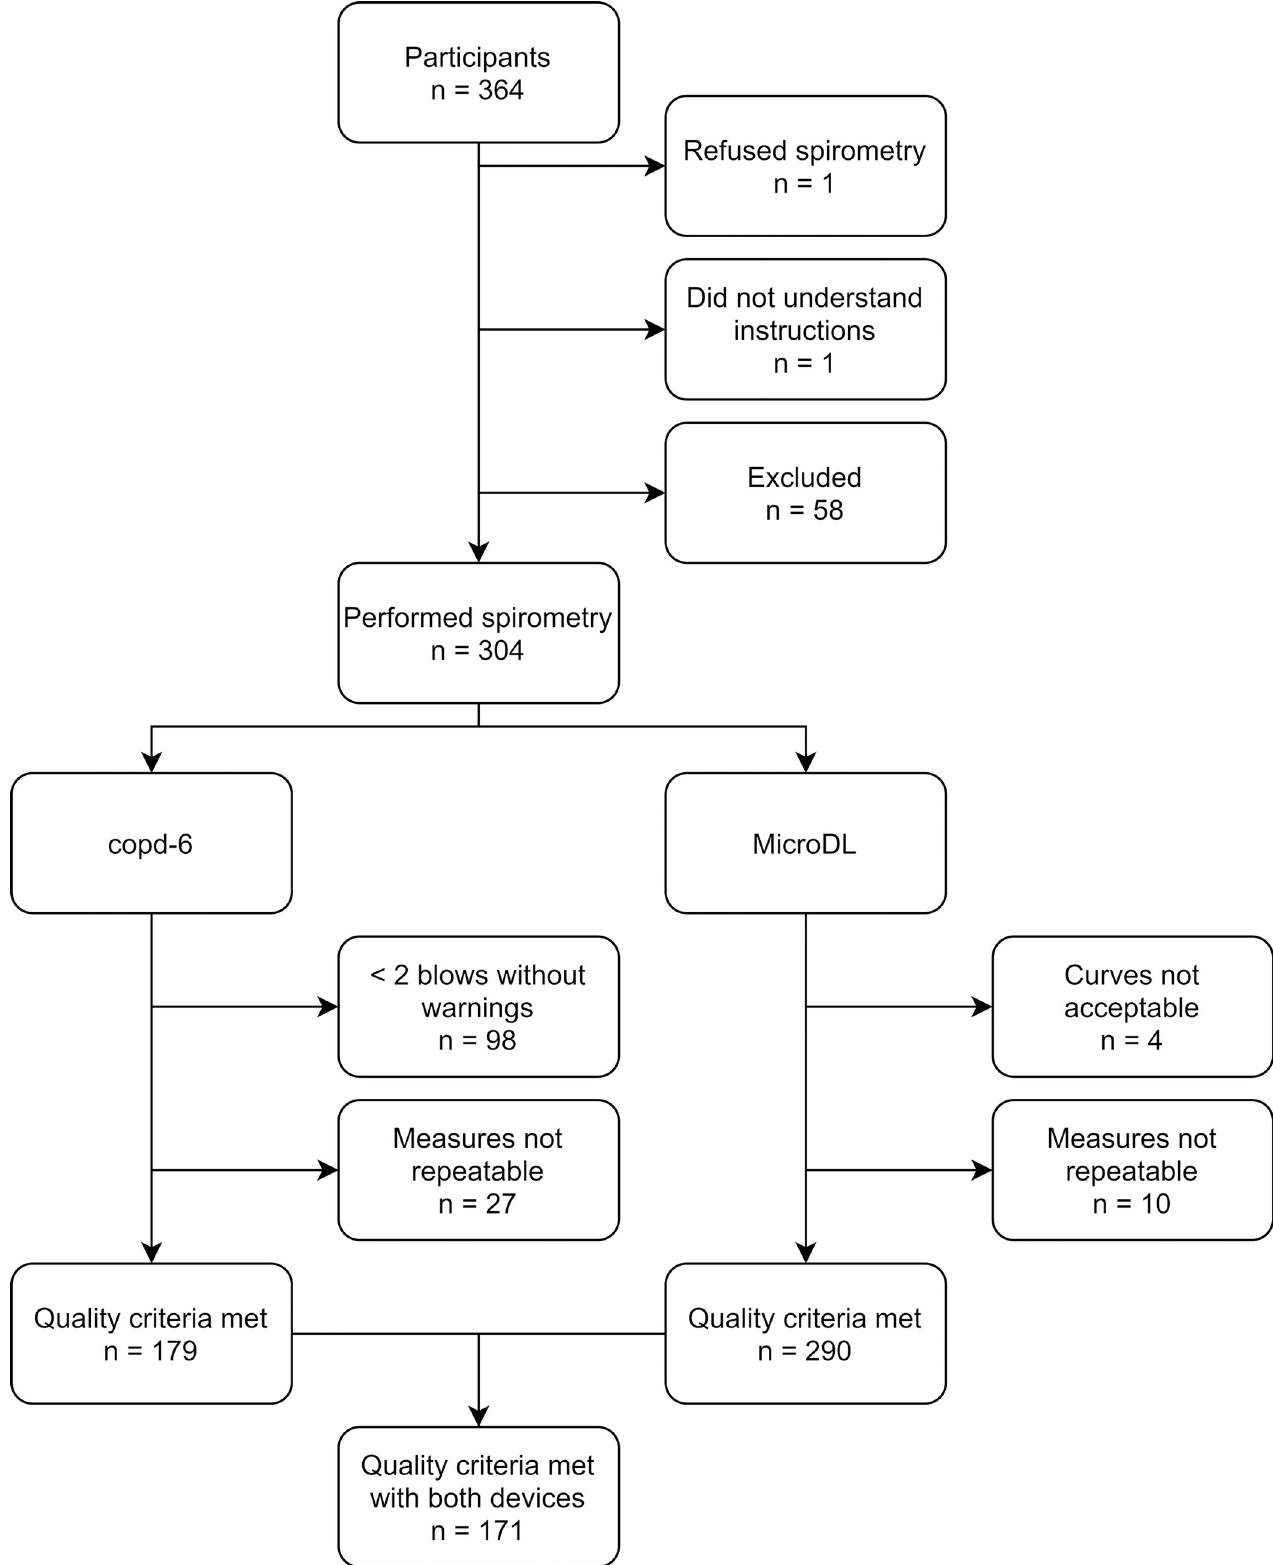
Fig 1. Overview of participant inclusion in analyses. https://doi.org/10.1371/journal.pone.0253319.g001 PLOS ONE | https://doi.org/10.1371/journal.pone.0253319 June 28,